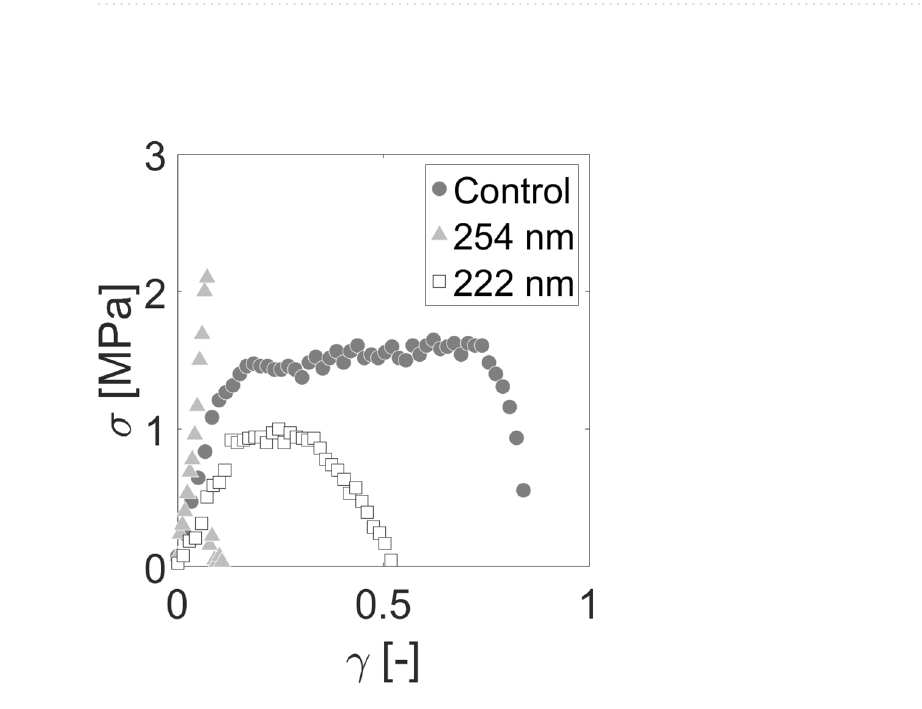
Figure 8. Loss of SC plastic deformability with UVC irradiation. Representative stress–strain plots of an unirradiated SC sample (dark grey circle), a sample irradiated with 200 J/cm 2 of incident 254 nm light (light grey triangle) and a sample irradiated with 200 J/cm 2 of incident 222 nm light (white square). All samples are equilibrated to 100%